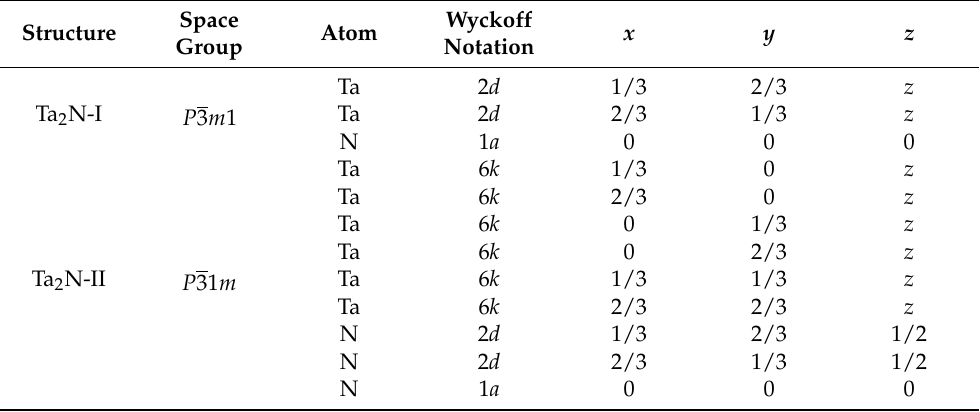
Table 1. Crystal structure information of Ta 2 N-I and Ta 2 N-II with space groups P 3 m 1 and P 31 m ,